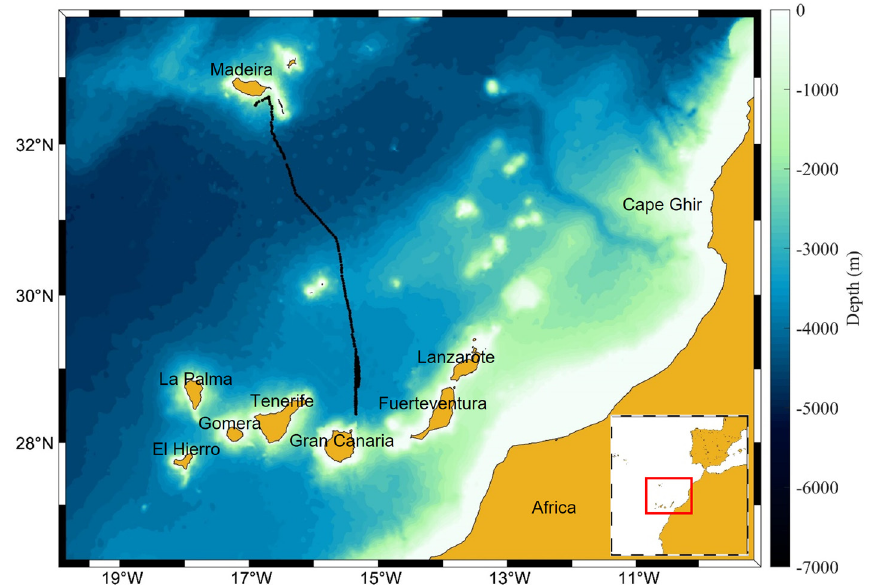
Figure 2. Meridional glider section starting in the south of Madeira Island and ending in the north of the island of Gran Canaria. The color scale shows the bathymetry of the area. The lower right box of the figure shows a map of the Northeast Subtropical Atlantic marked in red the study area corresponding to the Canary Islands basin.